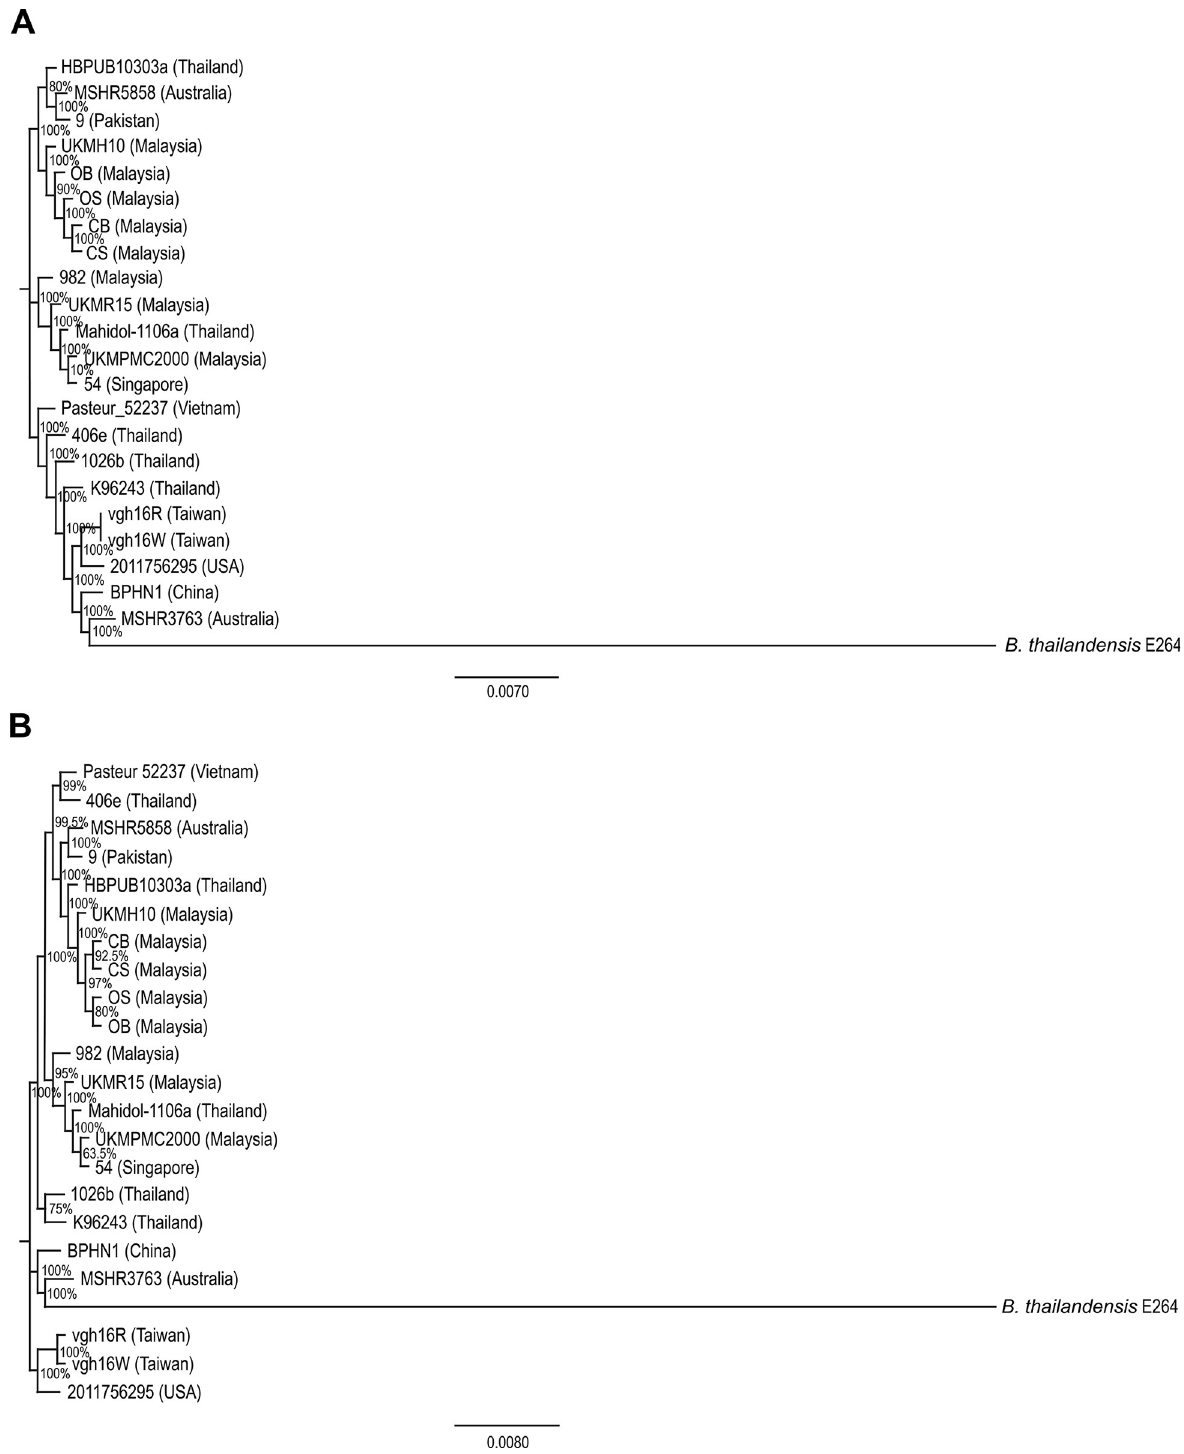
Fig 3. The phylogenomic tree inferred based on chromosome 1 (A) and chromosome 2 (B) of the representative Burkholderia pseudomallei strains. The core genome SNP-based alignment was generated by REALPHY server using B . pseudomallei strain K96243 (chromosome 1 (A) and chromosome 2 (B)) as the reference genome. The unrooted phylogenomic tree was inferred by approximately Maximum Likelihood (ML) method using Generalized Time-Reversible (GTR) model with gamma distribution of rates. 100 bootstrap replicates were used to infer the ML tree and the support value is indicated as a percentage at each node. The B . thailandensis strain E264 represents a phylogenetic outgroup.